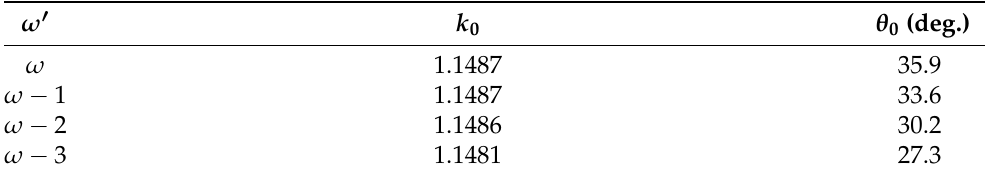
Table A3. Convergence of the position ( k 0 , θ 0 ) of the zero in f Ps with respect to the set ω (cid:48) = ω − i ,